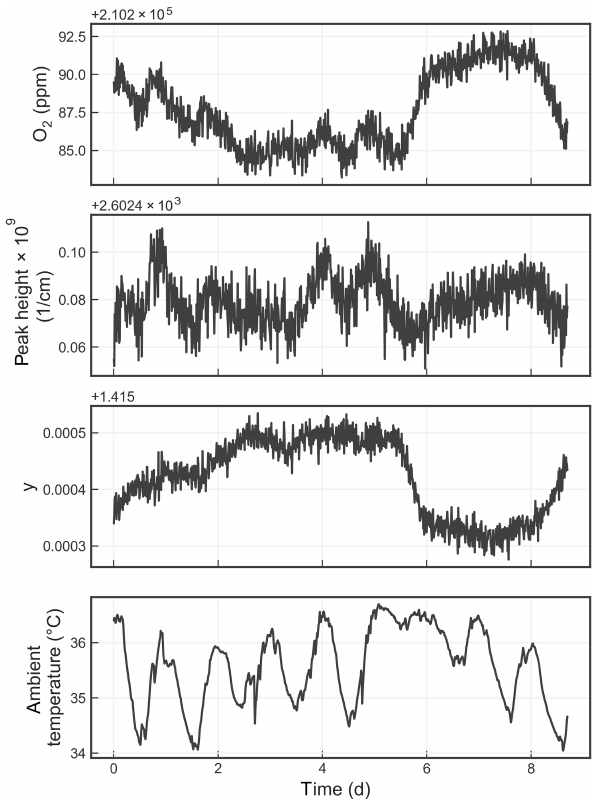
Figure 8. Time series from a measurement of a single tank over about a week. The four panels show the water-corrected oxygen concentration, the absorption peak loss minus the baseline loss, the measured Lorentzian broadening factor, and the ambient temper- ature (measured in the instrument housing), respectively. A win- dowed average of 300s was applied to all four data